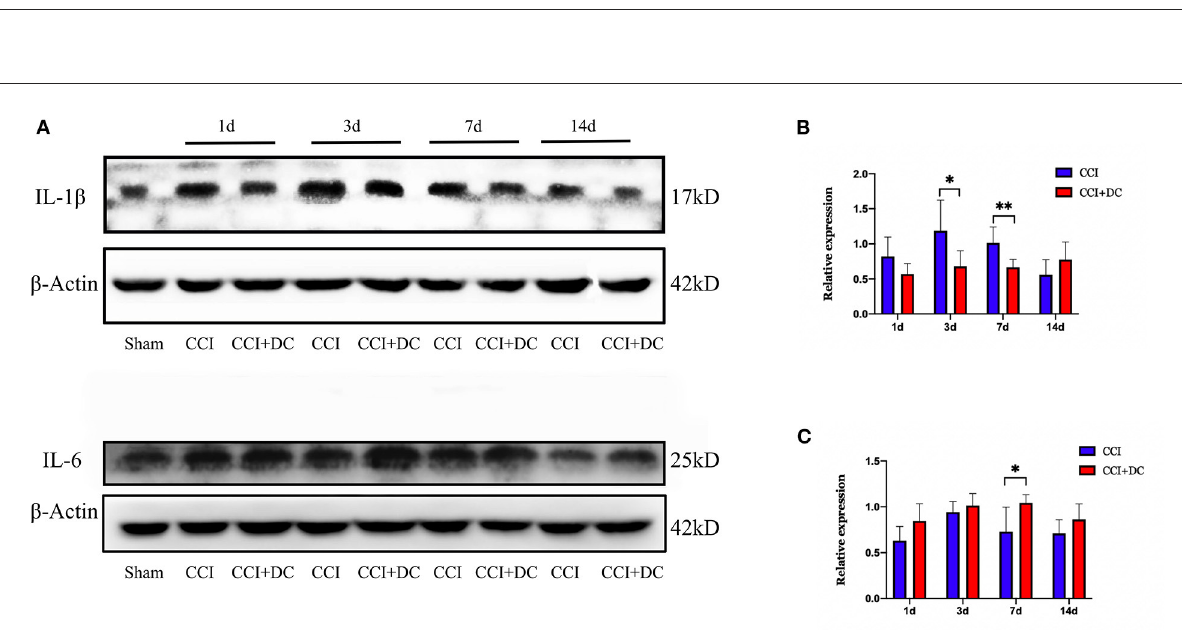
FIGURE9 The effect on inflammatory factors. (A) Expression changes of inflammatory factors IL1 β and IL6 on day 1, 3, 7, and 14 after CCI, and statistical results are shown in (B,C) . (B) ILI β in the CCI + DC group was significantly higher than that in the CCI group on the 3rd and 7th day after CCI. (C) IL6 in the CCI group was lower than that in the CCI group on the 7th day after CCI, and the results were also statistically different ( n = 6/group, * P < 0.05, ** P < 0.01, vs. CCI